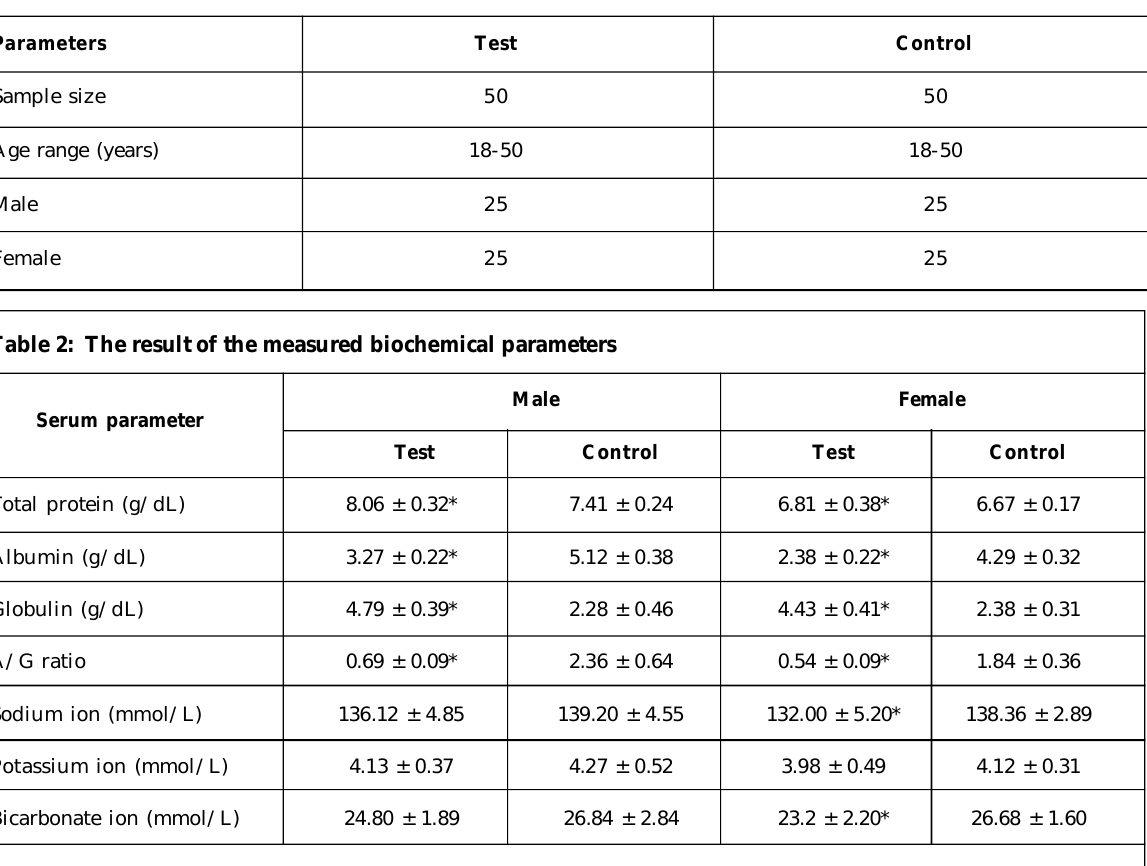
Table 1: The demographic data of the studied population Parameters